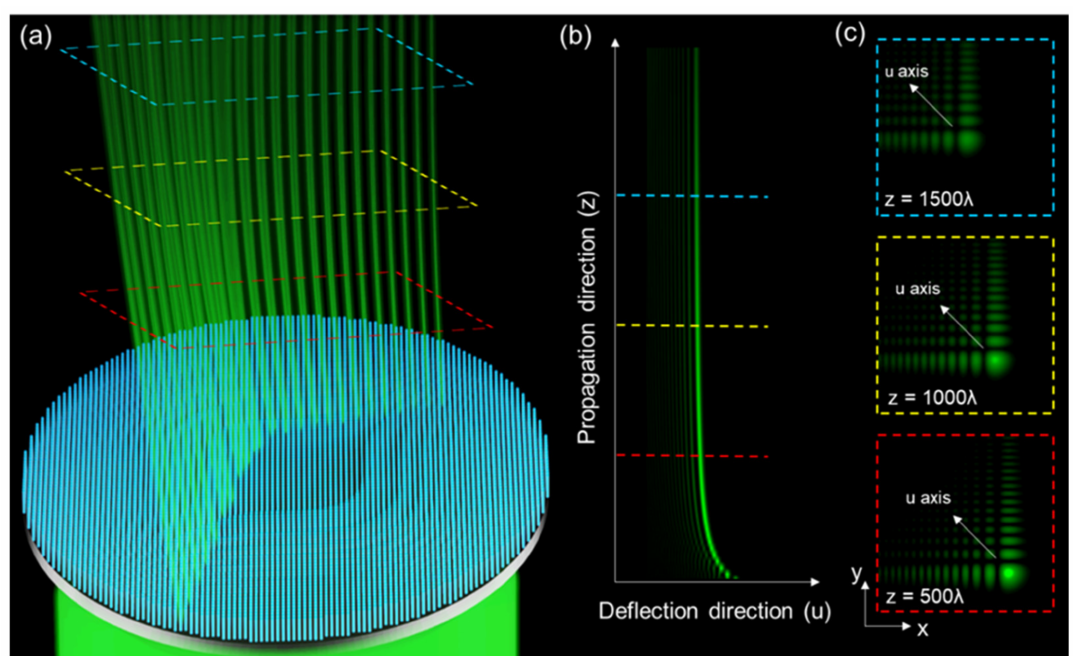
Figure 1. Propagation characteristics of a vertically accelerated 2D Airy beam. ( a ) Schematic diagram of generating a vertically accelerated 2D Airy beam by an all-dielectric cubic-phase metasurface. ( b ) Numerically calculated beam trajectory of a vertically accelerated 2D Airy beam along the u-z plane and the cross-section of intensity distribution at different propagation planes. ( c ) The deflection of the main lobe of a vertically accelerated 2D Airy beam is along the diagonal direction of the x-y plane, denoted as the u-